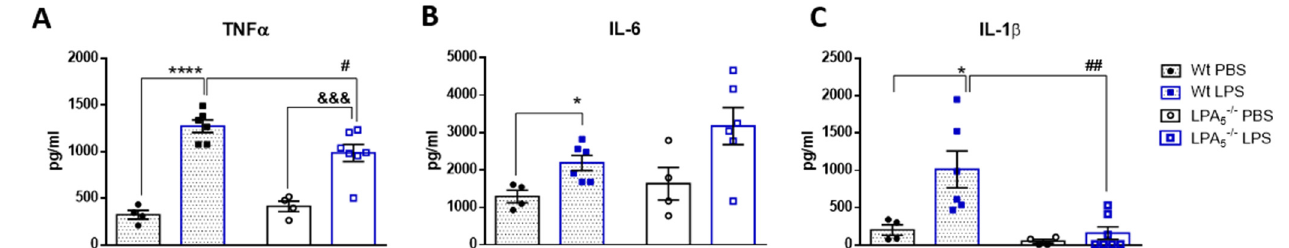
Figure 1. LPA 5 deletion attenuates peripheral TNF α and IL-1 β concentrations in LPS-injected mice. Wt and LPA 5-/- mice were injected i.p. with PBS ( n = 4) or LPS (5 mg/kg; n = 6). After 24 h, the animals were sacrificed, blood was collected and serum was isolated. The concentrations of ( A ) TNF α , ( B ) IL-6, and ( C ) IL-1 β were quantified using ELISAs. Values are expressed as mean ± SEM, * p < 0.05, **** p < 0.0001 compared to wt PBS control; &&& p < 0.001 compared to LPA 5-/- PBS control; # p < 0.05, ## p < 0.01 compared to LPS-treated wt mice; two-way ANOVA with Bonferroni correction).